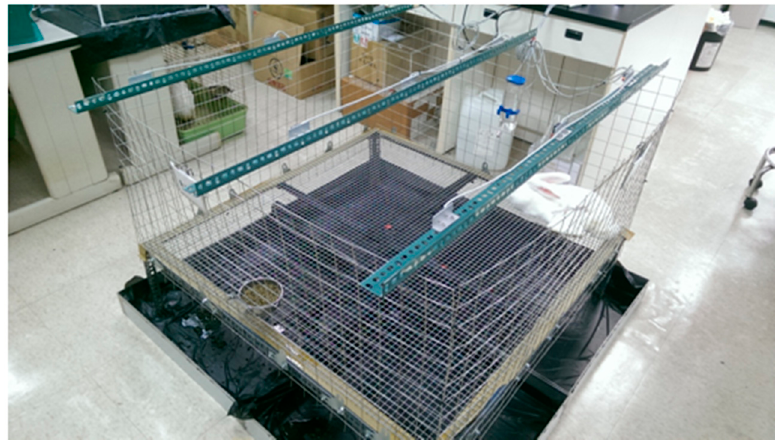
Figure 11. The animal behavior cage (ABC). The cage (1.2 × 1.2 × 0.7 m) consisted of a large floor and high walls.